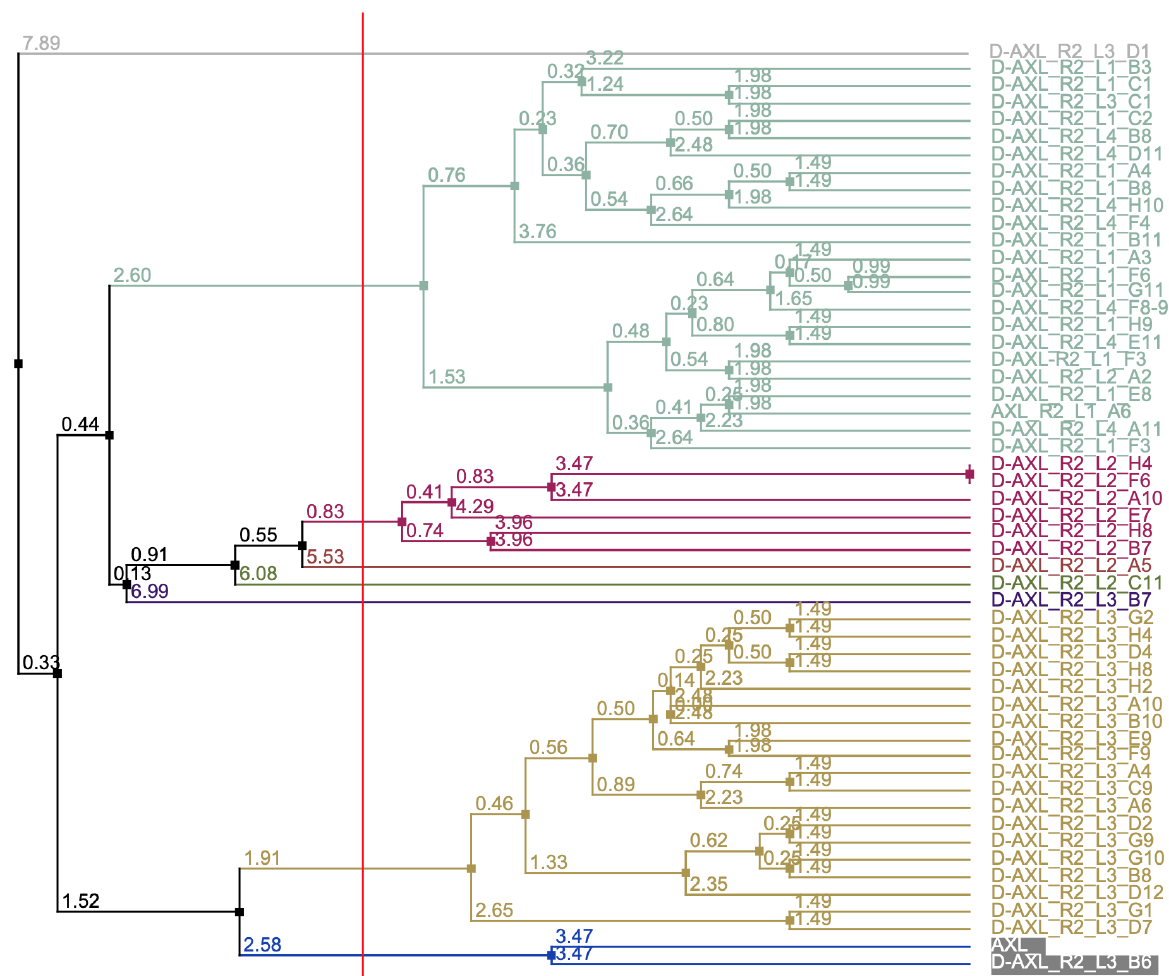
Figure 4. ( A ) Summary of phage display Pronectin Universal Fibronectin Libraries used for panning AXL-Fc Chimera recombinant protein. The four libraries underwent three rounds of panning and enrichment. Input titers are listed as cfu/mL, while output titers are cfu/mL from 0.1 M HCL elution